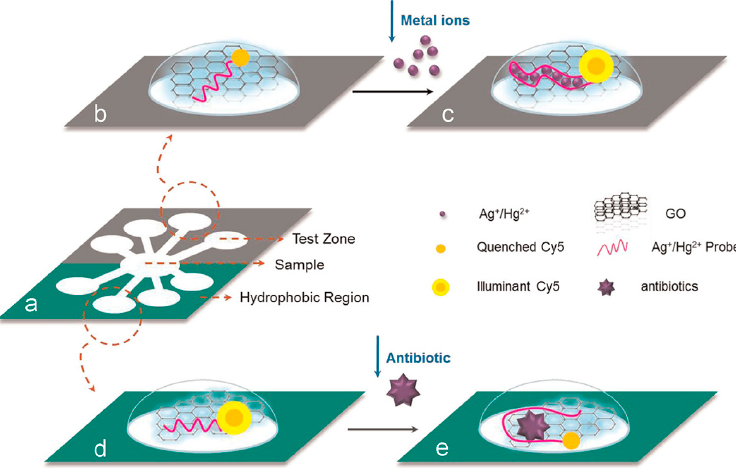
Figure 4. Schematic of the paper-based microfluidic device for multiplex chemical contaminants detection using ssDNA-functionalized GO sensors. Reprinted with permission from [111]. Copyright (2014) Elsevier.